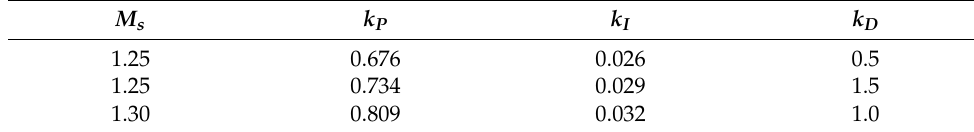
Table 10. PID sets for studying IAE distribution.